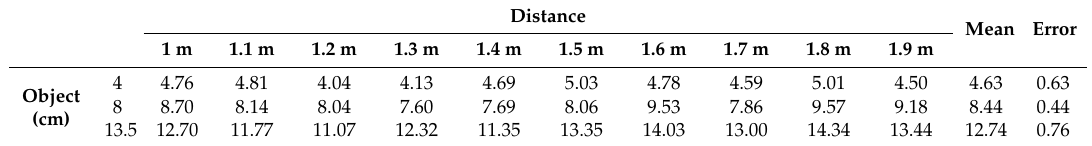
Table 2. A result of estimating different obstacle heights (in cm) at different distances (in m). Distance